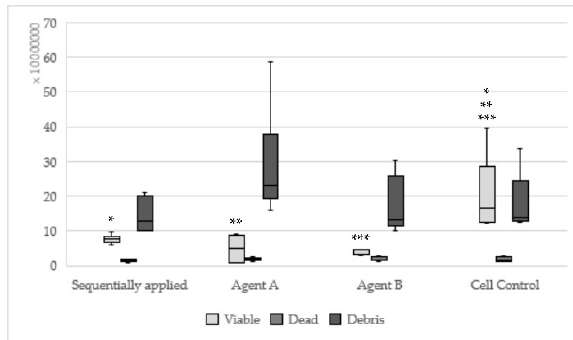
Figure 2. Results of hybrid bond sequentially applied, single applied (Hybrid base, hybrid brushes) and cell control; (sequentially applied vs. hybrid brushes * viable: p = 0.008 ** dead: p = 0.003; same asterisks show significant differences in the corresponding groups).